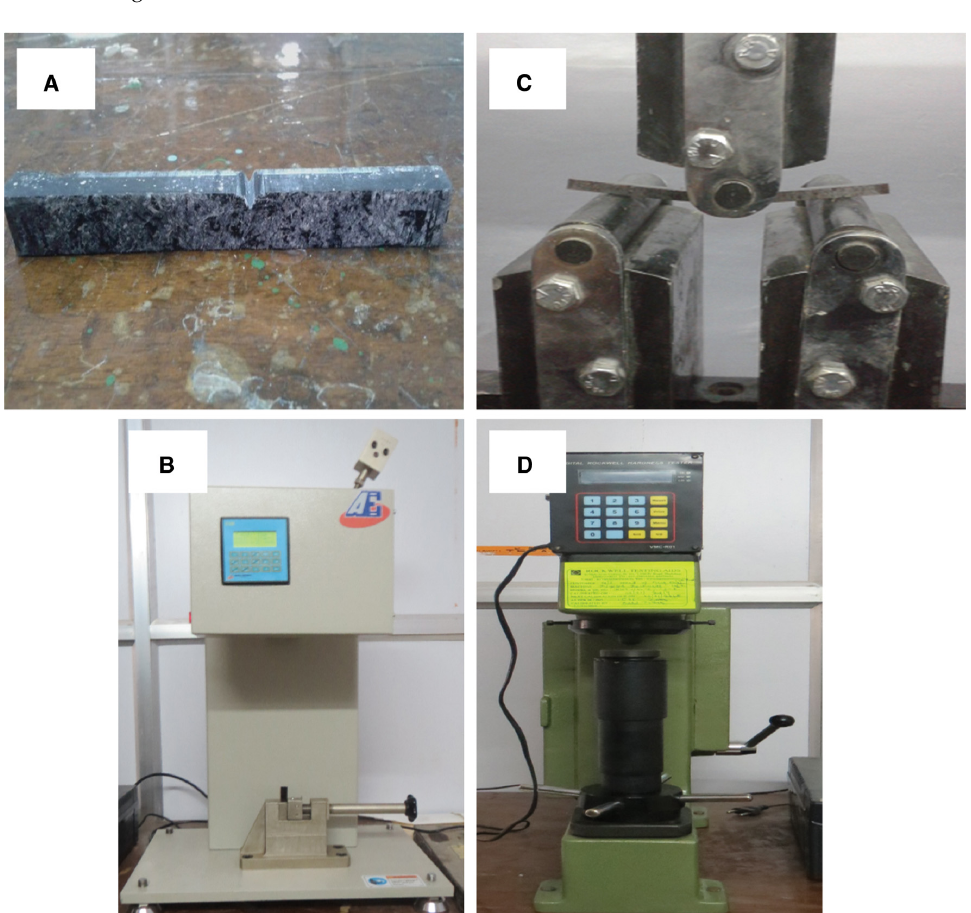
Figure 1: Universal testing machine.